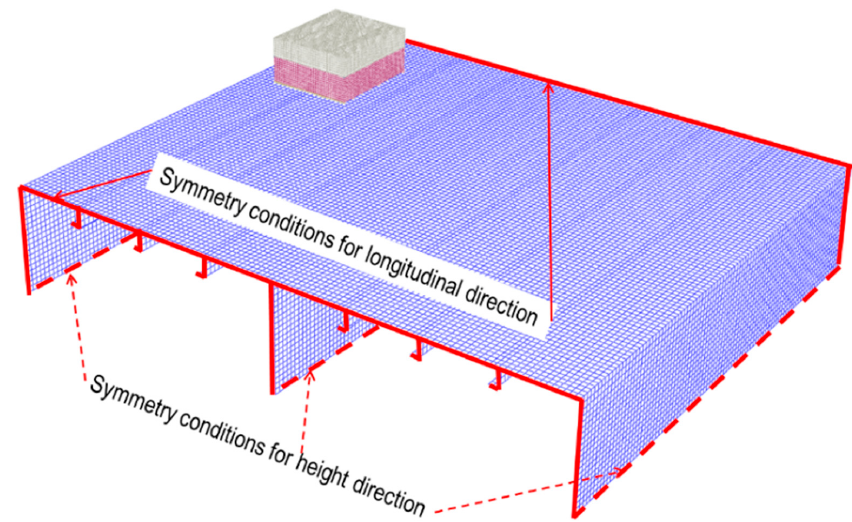
Figure 6. Boundary conditions for Model 3. Table 3. Material properties of the plywood panels [15].